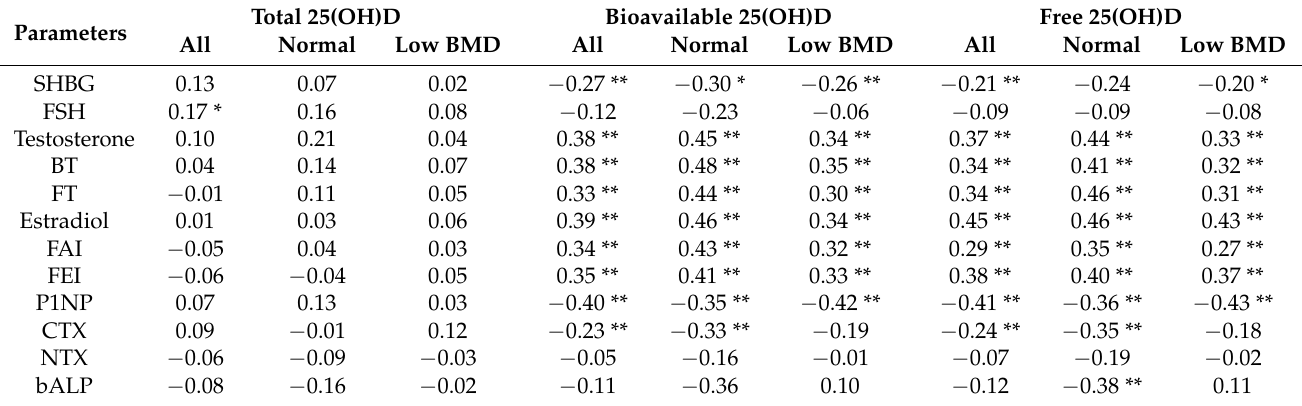
Table 4. Correlation between vitamin D metabolites and measured